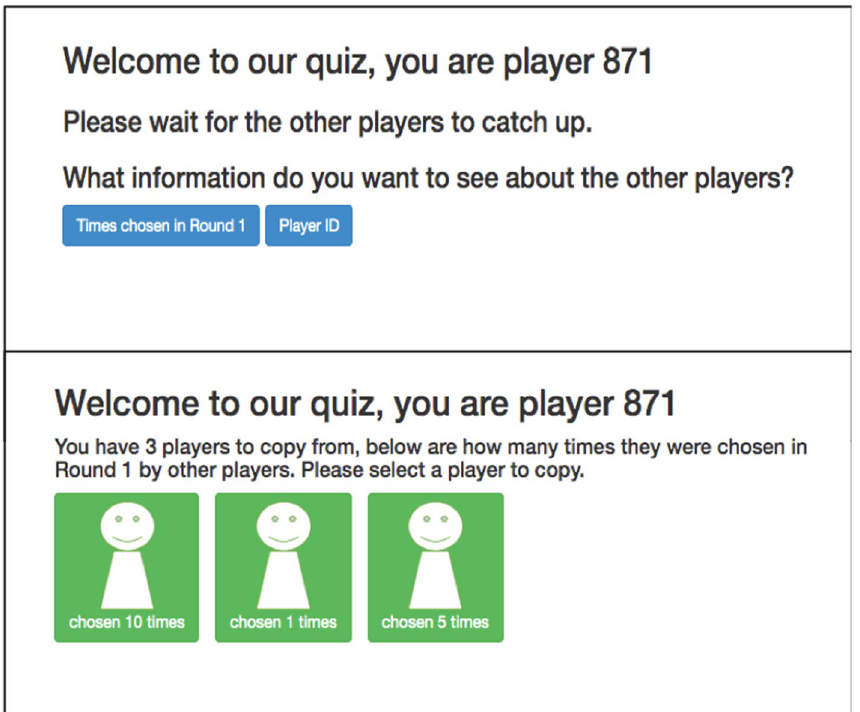
Figure 2. An example screenshot representing the choice a participant is given after selecting “Ask Someone Else” in Round 2 of the Prestige Condition and Control Condition (above) and an example choice after selecting “Times Chosen in Round 1” if three other players had answered the question (below).